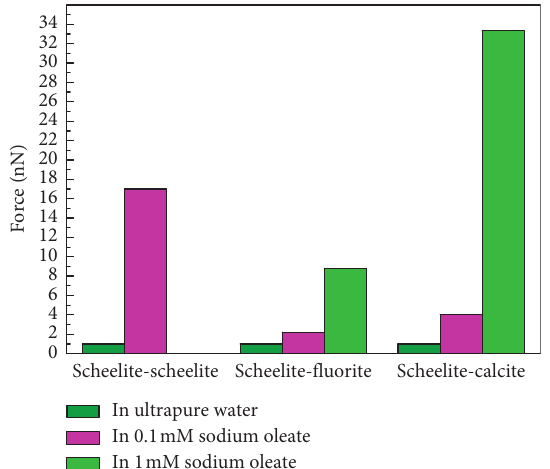
Figure 18: The force on scheelite-scheelite, scheelite-fluorite, and scheelite-calcite in approach curves at pH 10.